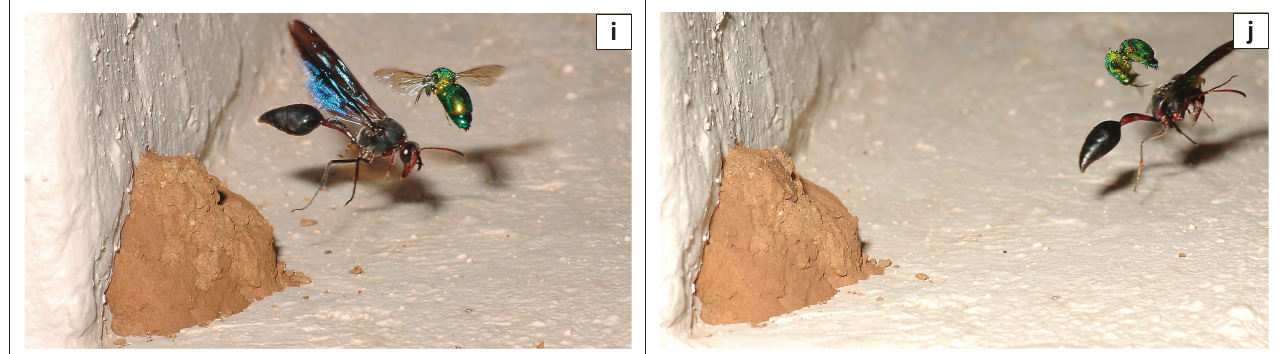
FIGURE 1 (Continues...): Nesting Delta sp. (Vespidae: Eumeninae) being attacked by two Stilbum cyanurum (Chrysididae) individuals. In between bouts of mobbing, the two S. cyanurum wasps would perch on the wall close to the nest (a)-(b). During bouts of mobbing, the two S. cyanurum wasps would simultaneously attack the Delta sp. from the air, actively harassing and dive-bombing her (c)-(h). The Delta sp. exhibited defensive behaviour, quivering her wings and facing her attackers, and would periodically fly at the mobbing S. cyanurum wasps (i) colliding with them in the air